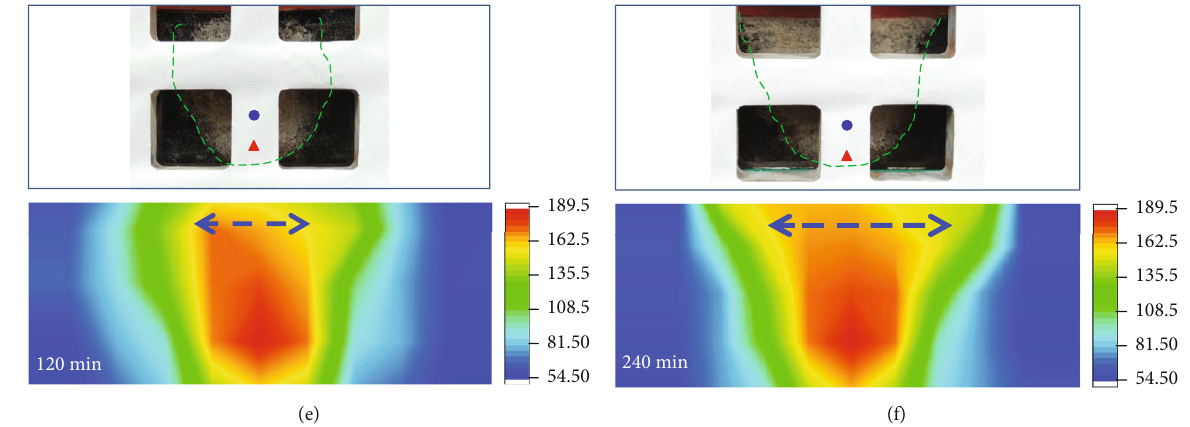
Figure 11: Pictures of steam chamber development and corresponding temperature pro fi